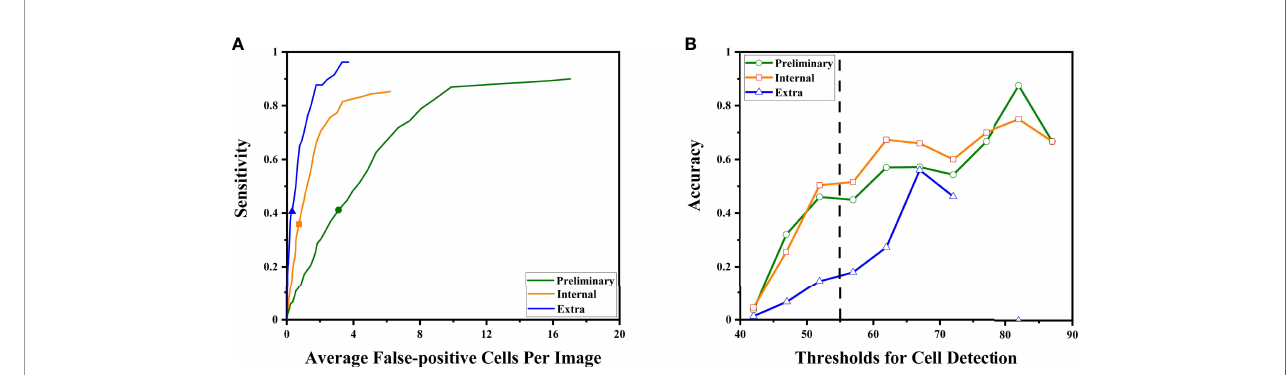
FIGURE 4 | The DLS performance to detect malignant cells is illustrated. (A) As the system tried to fi nd more malignant cells (to achieve higher sensitivity), it made more mistakes classifying benign cells as malignant. The sensitivities at the optimal threshold for three sets were marked. (B) The accuracy at different thresholds. Thresholds were represented by their middle value (for example, x = 52.5 represented the interval of 50 – 55 points). Higher thresholds tend to have better detection accuracy. The performance at the optimal threshold of 50 – 55 points is highlighted by the dashed line. At this point, the increasing rates began to